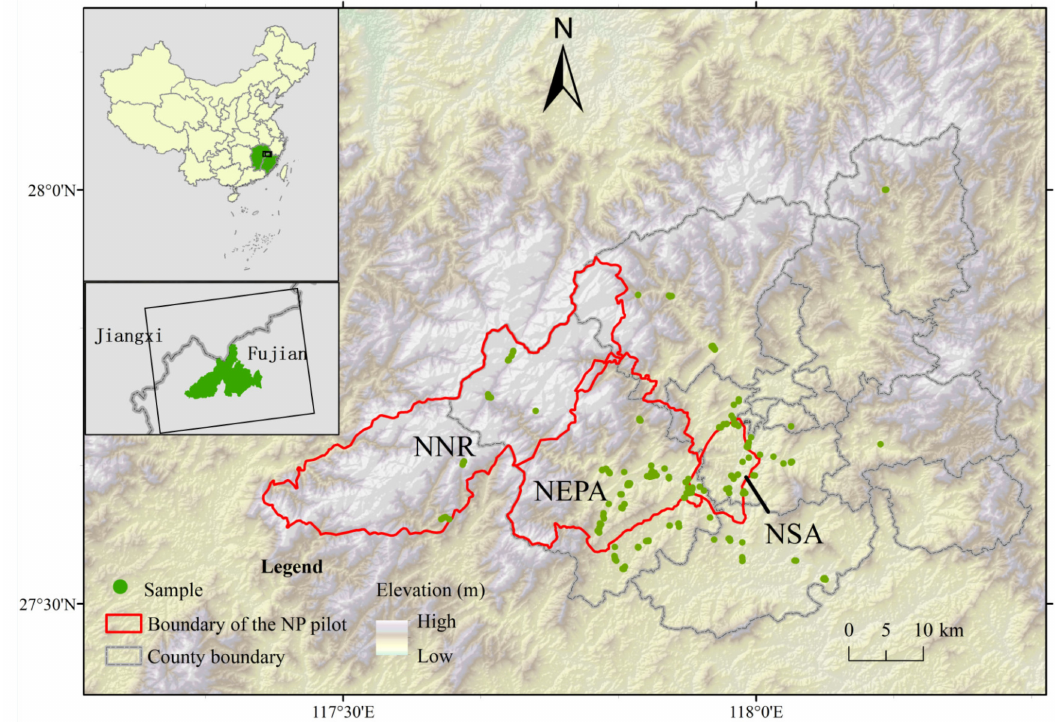
Figure 1. The location and composition of the Wuyishan national park pilot initiated in